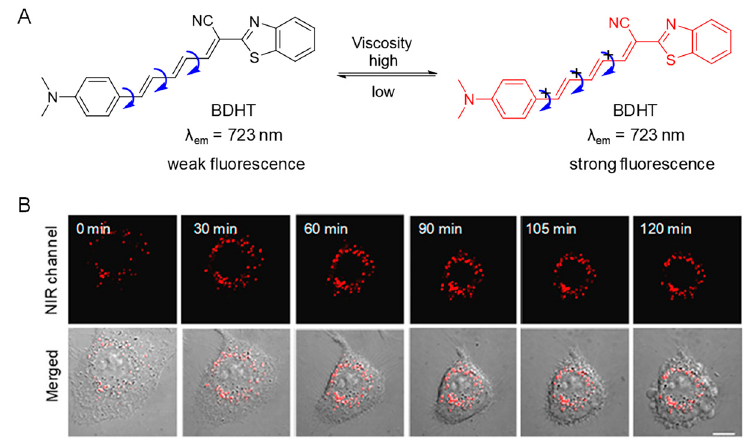
Figure 19. BDHT and its application in ferroptosis. ( A ) NIR fluorescence increase mechanism of BDHT with the increase in viscosity. ( B ) Imaging of LDs viscosity increase in erastin − induced ferroptosis of HeLa cells. Reprinted/adapted with permission from Ref. [81]. Copyright 2021, American Chemical Society.